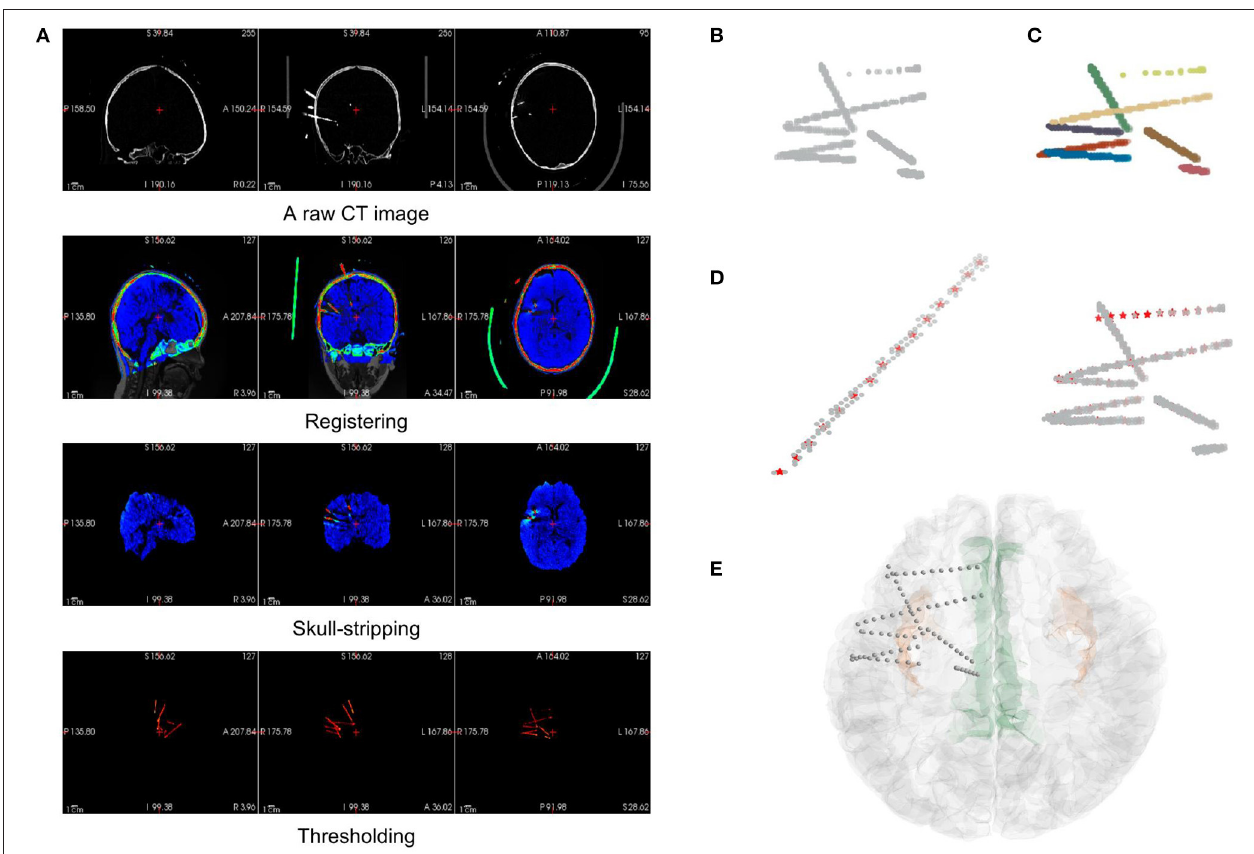
FIGURE 4 | The pipeline of electrode localization and contact segmentation procedures in the electrode module. (A) The preprocessing step includes image registration from the raw CT of a subject to MRI (orig.mgz after surface reconstruction), skull-stripping of registered CT (using brainmask.mgz after surface reconstruction), and thresholding of electrodes in the CT data. (B) The coordinates of electrode voxels in the CT image after thresholding can be extracted and plotted, viewing as a mix of point clouds. (C) After applying a Hough Transform and Gaussian Mixture Model algorithm, the electrodes are clustered and labeled by different colors. (D) Contact segmentation step: contact positions are recognized one by one by converging to the center-of-mass based on voxel values. Contact positions are marked as red asterisks. (E) The results of the contact segmentation pipeline are projected onto the 3D surface